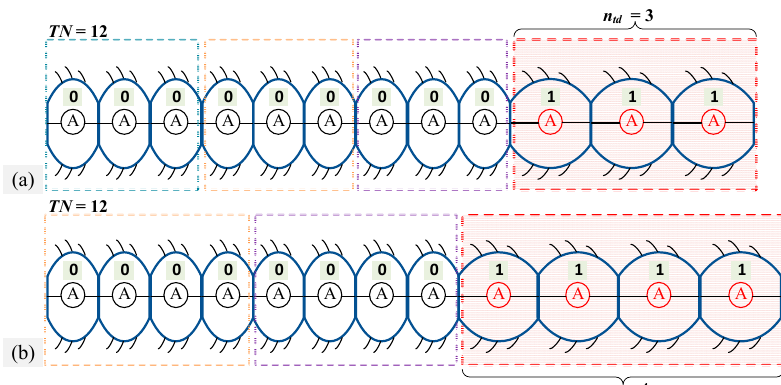
Figure 3. The initial distribution of the U-DM for a 12-segment earthworm-like locomotion robot. ( a ) The initial distribution of the U-DM with three actuated segments. ( b ) The initial distribution of the U-DM with four actuated segments.